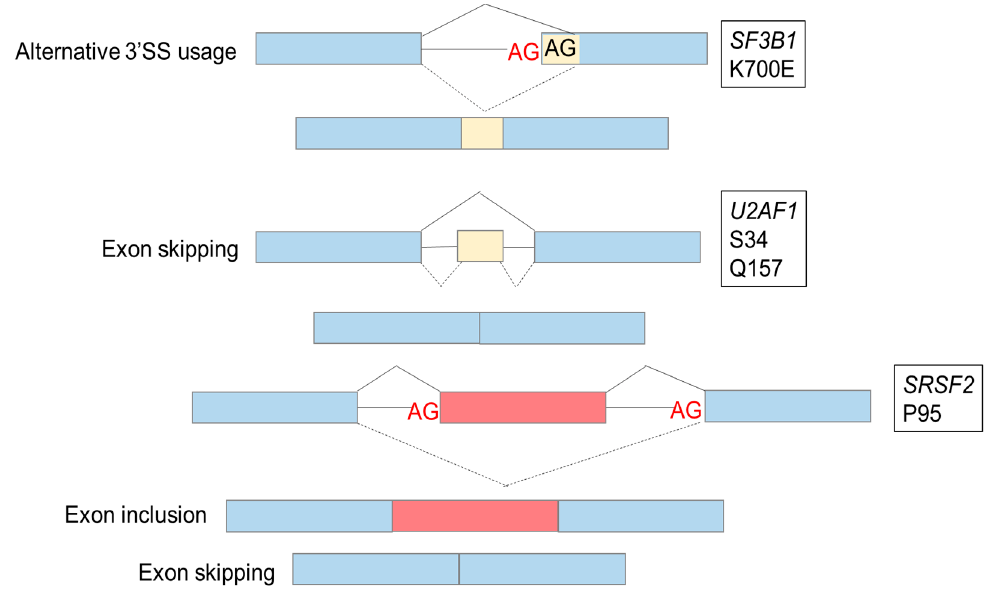
Figure 2. Consequences of mutations in splicing factors. Examples of consequences of splicing factors